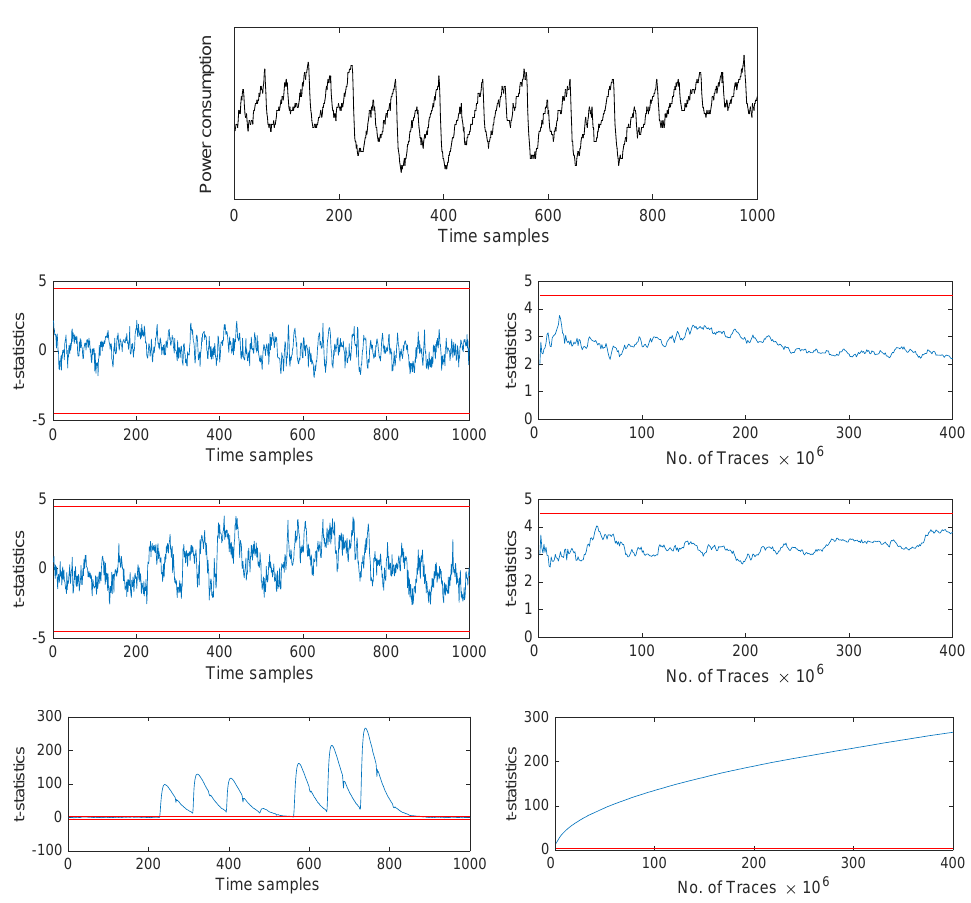
Figure 11: Sample power trace and univariate non-specific t -test results with 400 million measurements for two composed UMA multiplications with d = 2, based on GF (2 4 ) multipliers. The second to fourth rows show the t -statistics for the statistical moments 1 to 3, respectively, arranged like before.